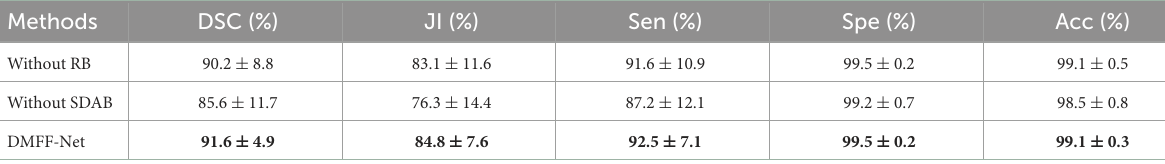
TABLE 4 Effect of different encoding blocks in the dual encoding path on network performance.